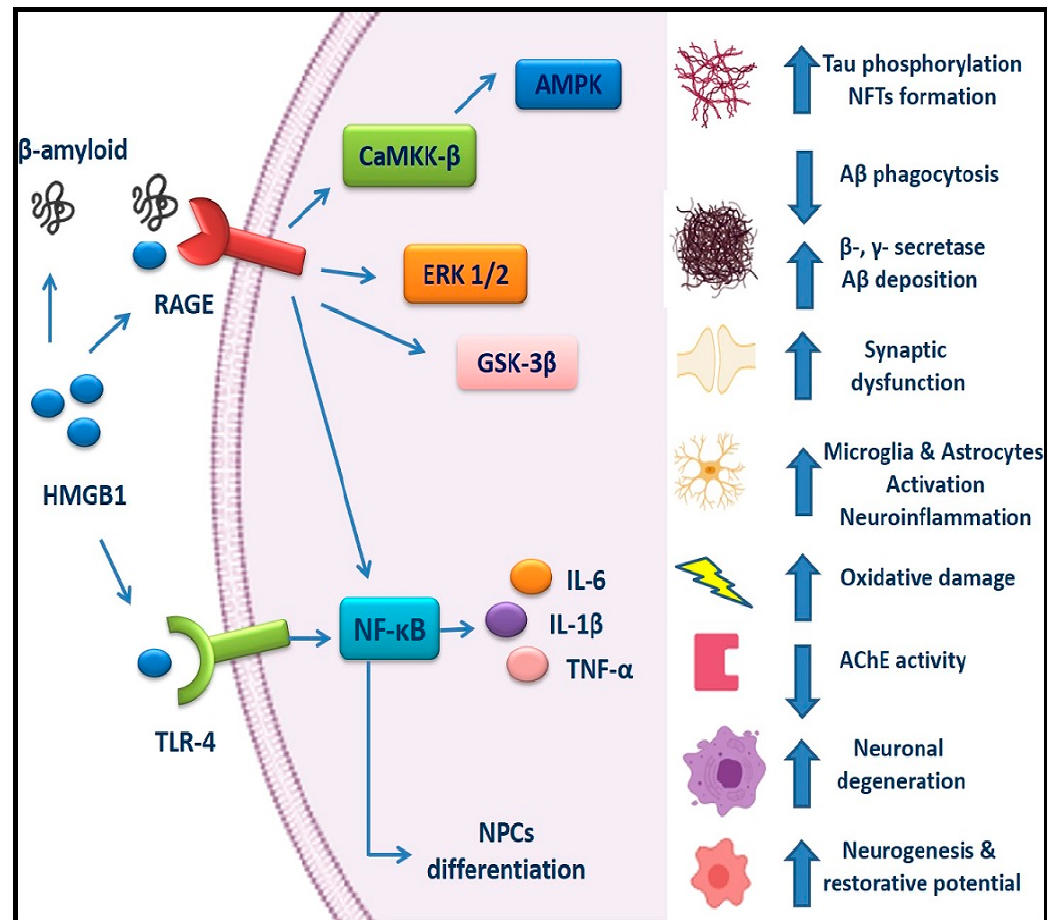
Figure 1. HMGB1/RAGE and HMGB1/TLR4 signaling pathways in AD: HMGB1 can interact with extracellular A β peptides and decrease A β deposition by inhibiting A β clearance by microglia, as well as increasing β - and γ -secretase activity. RAGE enhances production of A β , abnormal Tau hyperphosphorylation, and NFTs formation. HMGB1/RAGE and HMGB1/TLR4 signaling induce neuroinflammation by activating the NF- κ B pathway, increasing production of pro-inflammatory cytokines including TNF- α , IL-6, and IL-1 β , activating microglia and astrocytes in a reactive and inflammatory state, and thus aggravating the AD pathogenesis through a vicious cycle of inflammation and oxidative damage. RAGE/CaMKK- β -AMPK, the RAGE/ERK1/2, RAGE/GSK-3 β , and RAGE/NF- κ B pathways have been involved in the regulation of abnormal Tau hyperphosphorylation and A β pathology. RAGE signaling has been also implicated in synaptic dysfunction, reduced AChE activity, and neurodegeneration. However, activation of RAGE/NF- κ B pathway by HMGB1 in adult NPCs promotes neuronal differentiation and formation of new neurons, leading to increased adult neurogenesis. In addition, HMGB1 may play dual roles in AD pathogenesis, since it can also contribute to reparative mechanisms in the AD brain. AD, Alzheimer’s disease; HMGB1, High mobility group box 1; RAGE, Receptor for advanced glycation end products; TLR4, Toll-like receptor 4; A β , Amyloid beta; NFTs, Neurofibrillary tangles; CaMKK- β ,Ca 2+ /calmodulin-dependent protein kinase kinase- β ; ERK1/2, Extracellular signal regulated kinase ½; NPCs, Neural progenitor cells; IL, Interleukin; NF- κβ , Nuclear factor κ light chain enhancer of activated β cells; TNF- α , Tumor necrosis factor- α .